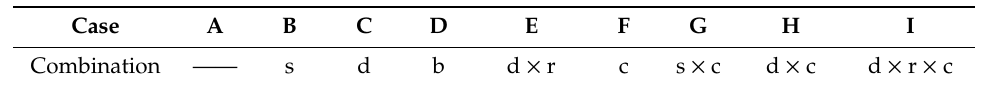
Table 1. The adjustment of spatial shape.